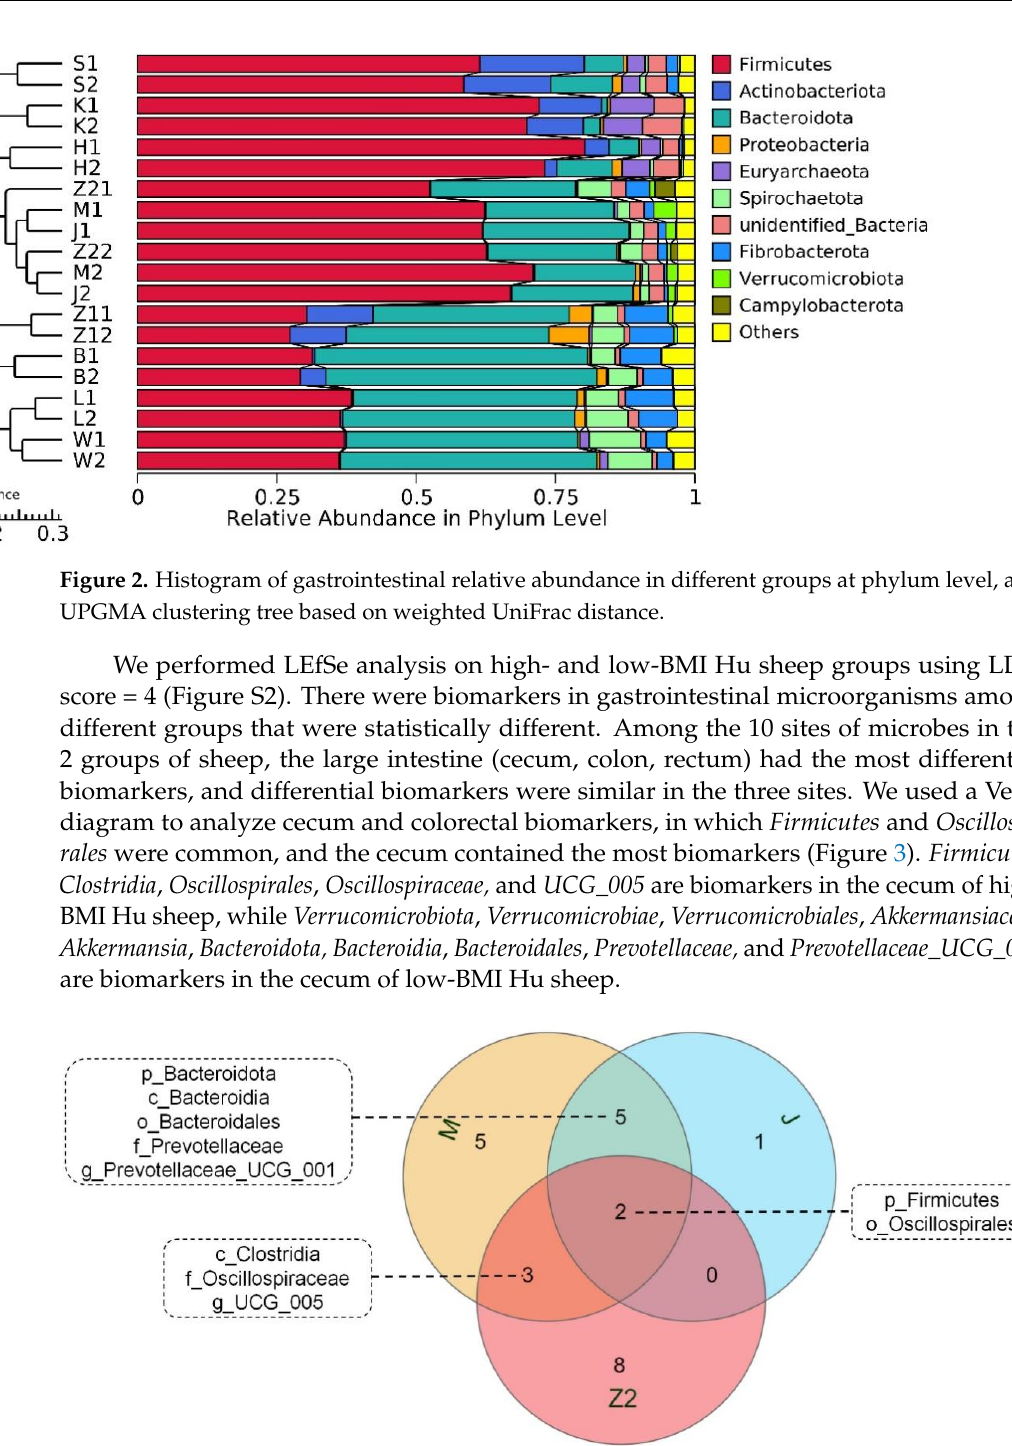
Figure 4. Dfferences in microbes at cecal phylum level in Hu sheep with different BMI. ( A ) Phy ‐ lum level; ( B ) difference in ratio of Firmicutes to Bacteroidetes .